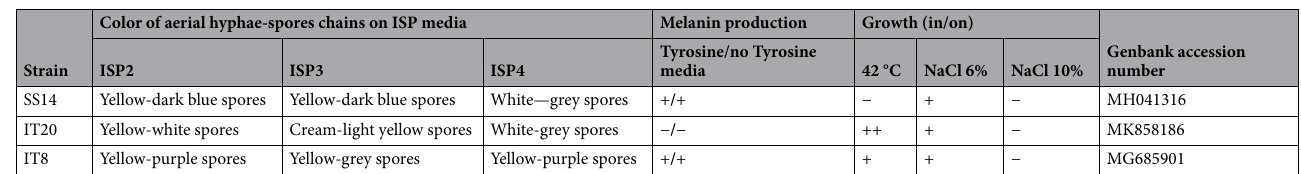
Table 2. Phenotypic and molecular characteristics of two selected strains. +: presence or growth −: lack or no growth.